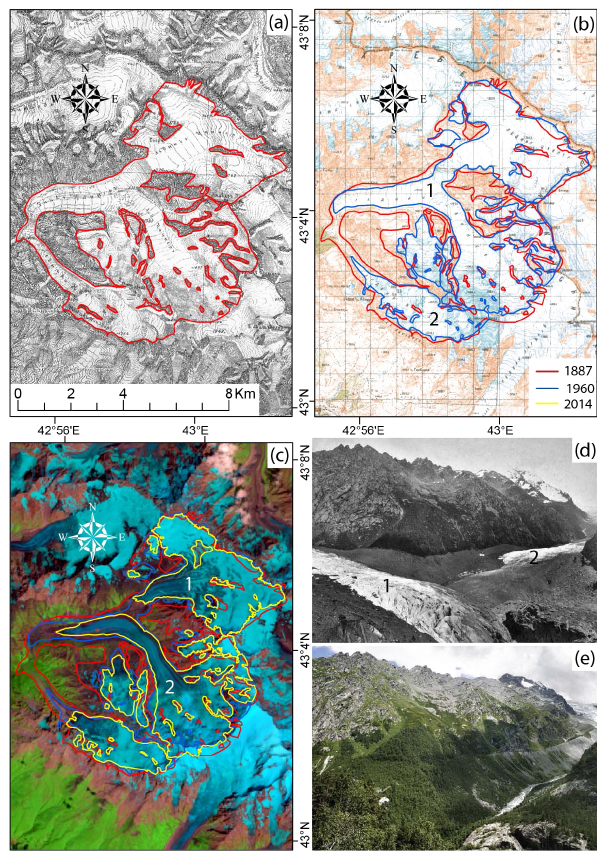
Figure 3. (a) Tsaneri Glacier, topographical map 1887; (b) topo- graphical map 1960, 1 Tsaneri Glacier, 2 Nageba Glacier; (c) Land- sat L8 imagery, 1 northern Tsaneri Glacier, 2 southern Tsaneri Glacier; (d) 1 Tsaneri and 2 Nageba glaciers confluence in 1884 (photo by M. V. Dechy); (e) the same view in 2011 (photo by F. Ven-